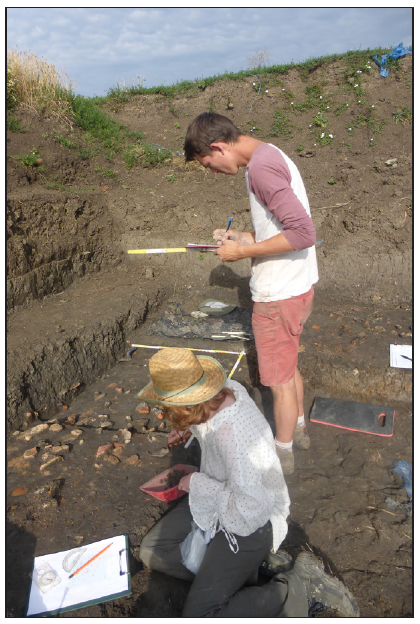
Figure 2: IoA students on fieldwork working in Romania, Tasnad, 2018 (Photo: Ulrike